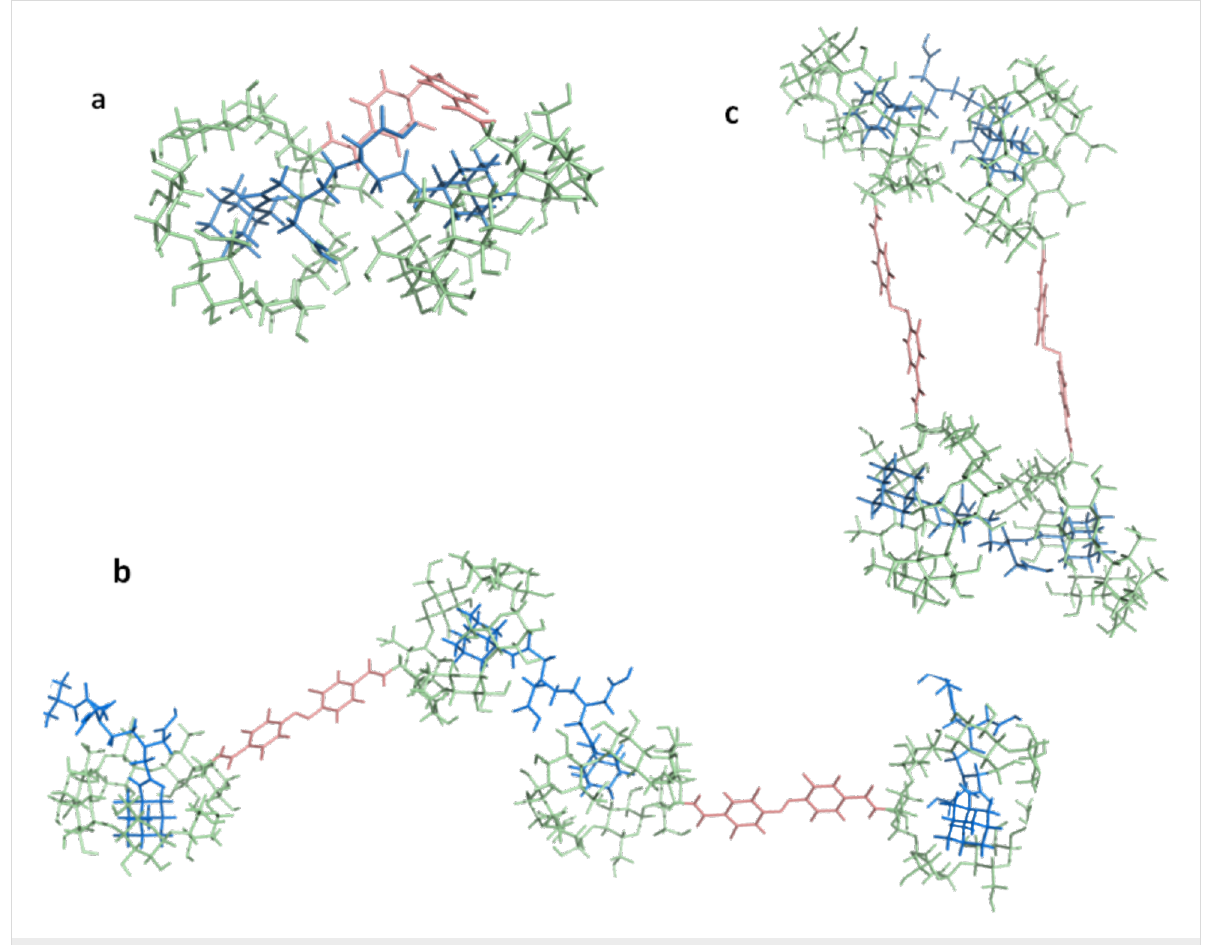
Figure 8: Proposed structures of inclusion complexes with the ditopic host AZO-CDim 1 and the ditopic guest ADAdim 4 after minimization by molec- ular modeling methods: (a) 1:1 chelate-type complex with AZO-CDim 1 in its cis configuration; linear (b) and cyclic (c) supramolecular polymers with AZO-CDim 1 in its trans